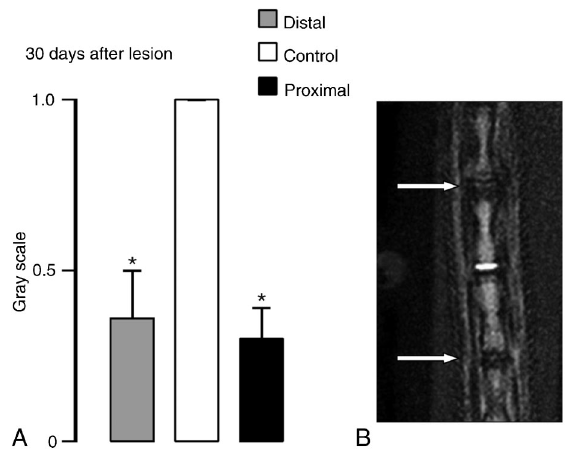
Figure 3. Normalized magnetic resonance imaging (MRI) signal evaluated 30 days after lesion in the three discs. A , Punctured distal (Co8-9) and proximal (Co6-7) discs showed a significant decrease of MRI signal compared to control. We did not detect any difference in MRI signal between proximal and distal segments. *P , 0.05 compared to control (paired t -test). B , MRI T2-weighted signal of punctured discs Co8-9 (top arrow) and Co6-7 (bottom arrow) and the intermediate disc as a control (Co7-8).